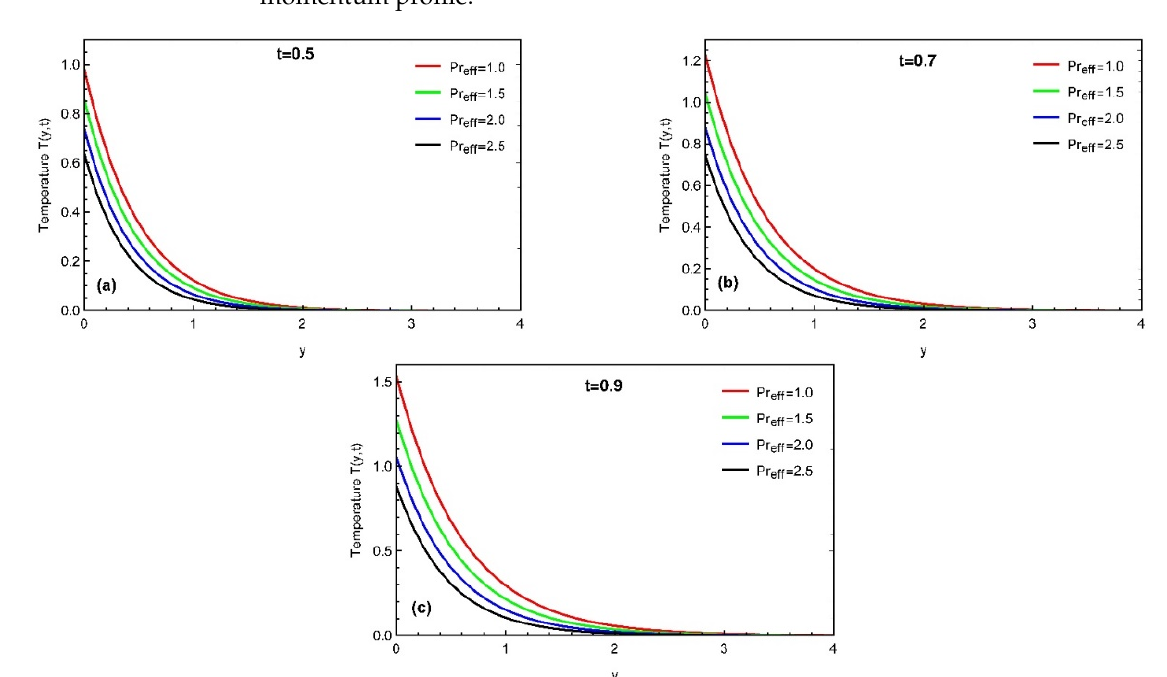
Figure 2. Variation in temperature due to fractional constraints at ( a ) 𝑡 = 0.5 ( b ) 𝑡 = 0.7 ( c ) 𝑡 = 0.9 .